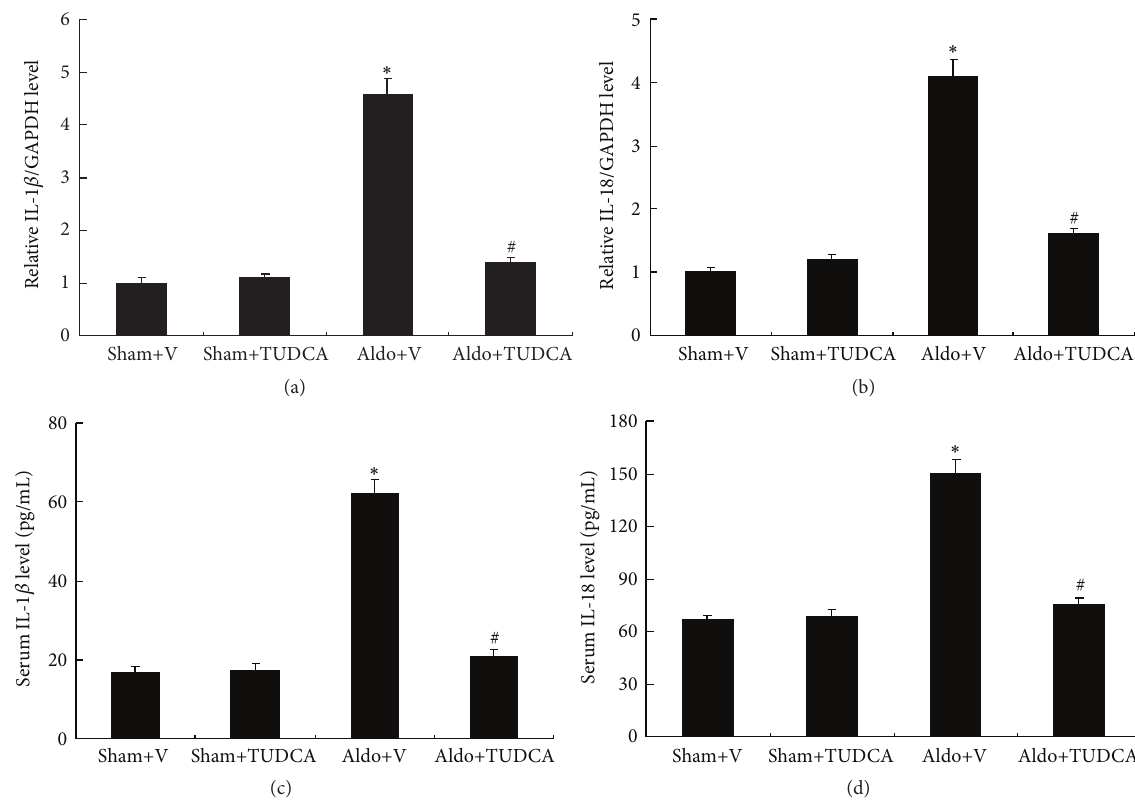
Figure 5: TUDCA decreased IL-1 𝛽 and IL-18 levels in Aldo-infused mice. (a) Relative mRNA expression of IL-1 𝛽 to expression of GAPDH. (b) Relative mRNA expression of IL-18 to the expression of GAPDH. (c) Serum IL-1 𝛽 levels and (d) serum IL-18 levels. Values are mean ± SEM ( 𝑛 = 6 ). ∗ 𝑝 < 0.05 , Sham+V group versus Aldo+V group, # 𝑝 < 0.05 , Aldo+V group versus Aldo+TUDCA